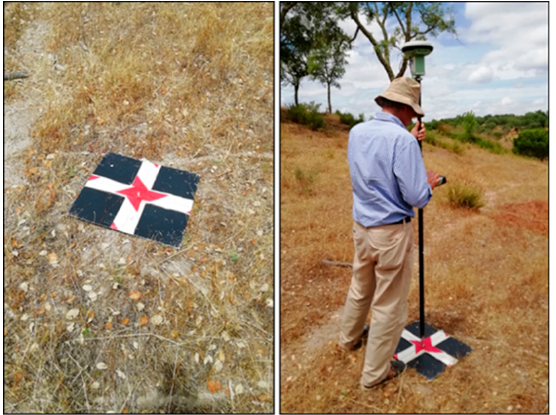
Figure 3. In situ photos of GCP used to rectify the UAV imagery.